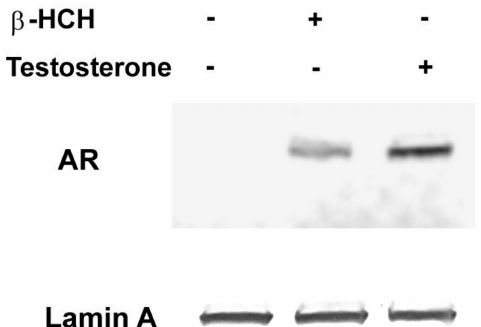
Figure 1. Androgen receptor (AR) nuclear localization in LNCaP cells. Western blot analysis was performed on nuclear extracts obtained from LNCaP cells exposed for 4 h to 10 µ M β -hexachlorocyclohexane ( β -HCH) or 30 nM testosterone. Treated samples exhibit an increase in AR nuclear localization compared to the control. Lamin A was used as a specific nuclear marker and normalization protein. The experiment was repeated three times and a representative blot is reported.